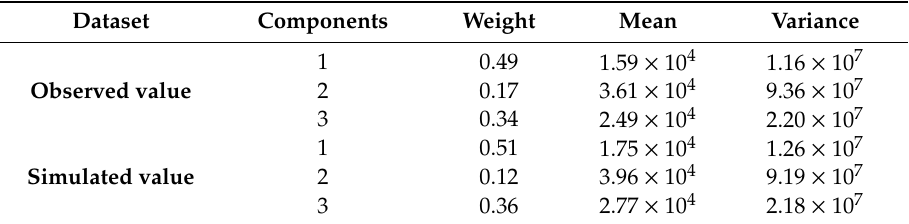
Table 2. Estimated parameters of GMM distributions under e ff ective